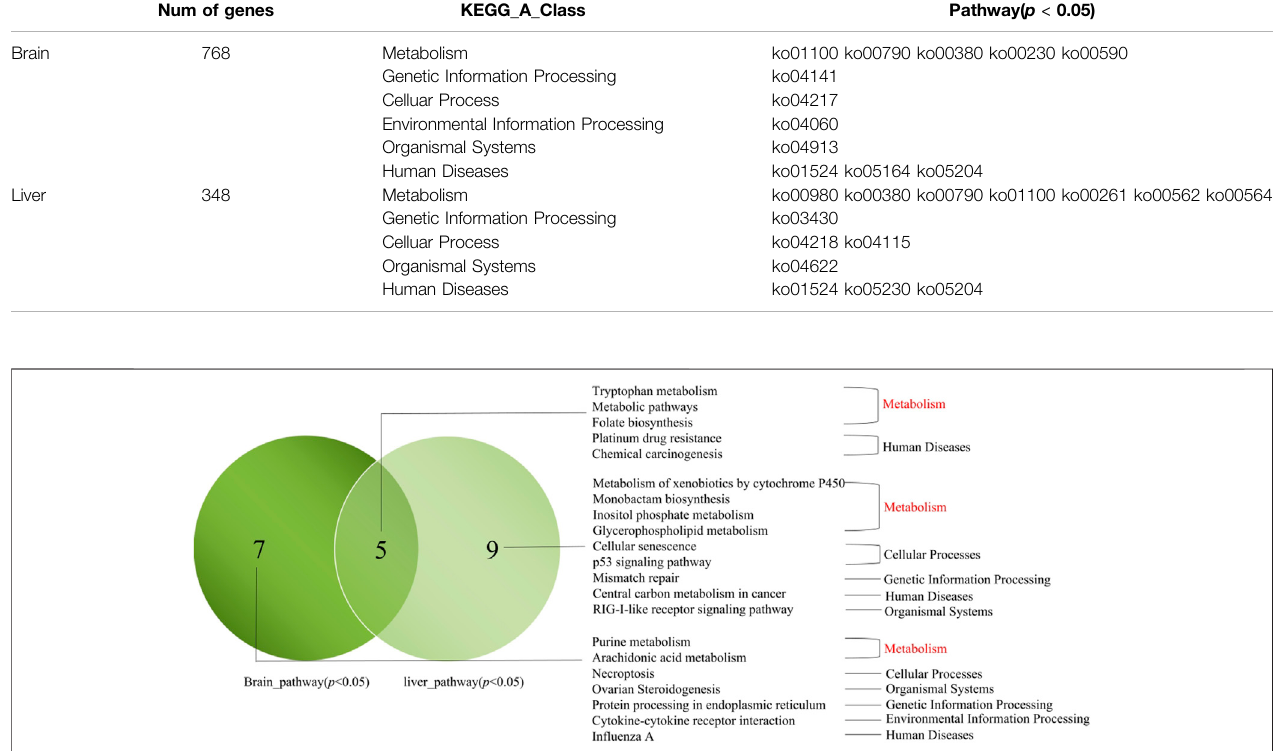
FIGURE8| Vennmap ofpathways betweenthebraincandidate genesinthebrainand liver. Note: Delineated withinthe darkgreen circlewasthepathways which enriched for candidate genes in the brain ( p < 0.05). Delineated within the light green circle was the pathways which enriched for candidate genes in the liver ( p < 0.05). The middle cross section showed the common pathways enriched. The main pathways were listed in this fi gure.